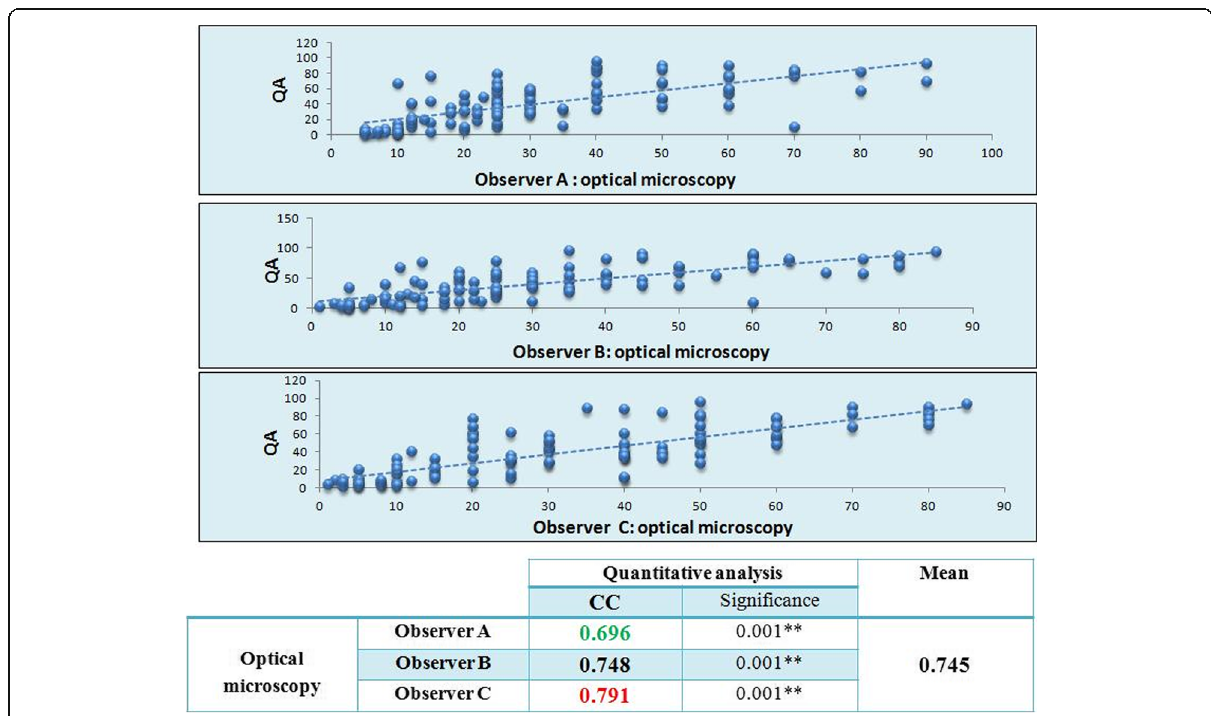
Fig. 3 Correlation between manual assessment of Ki67 on optical microscopy and automated assessment results using continuous